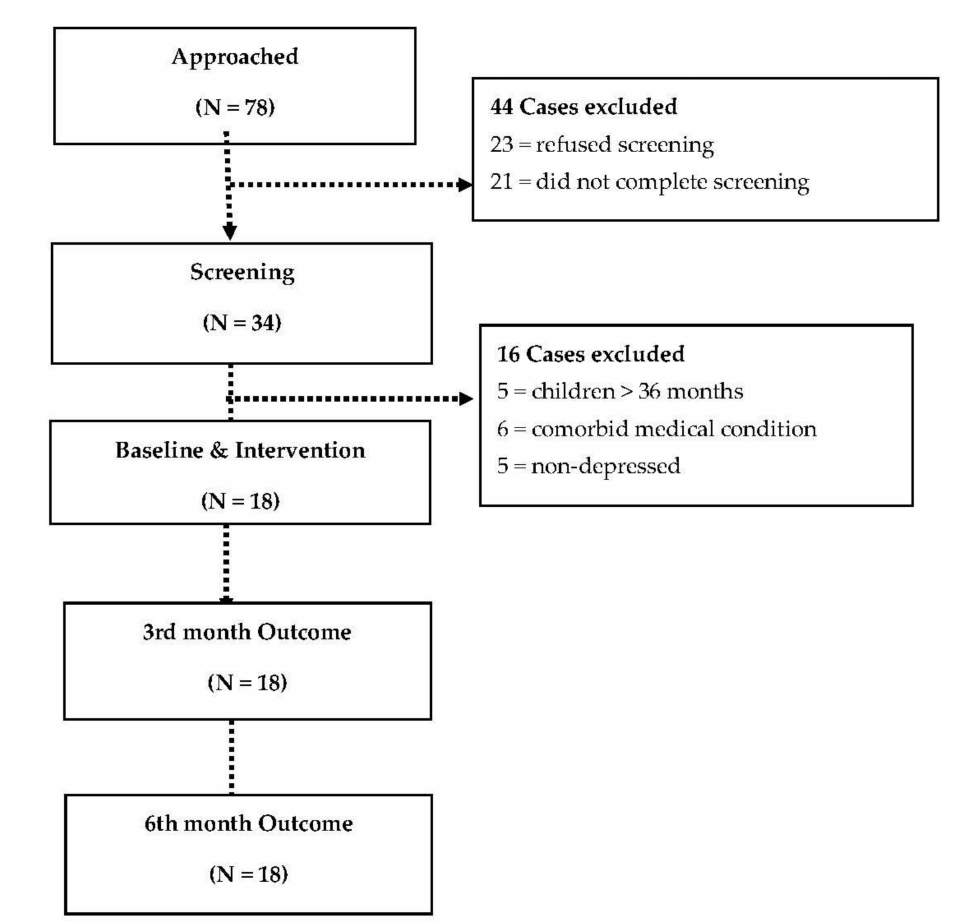
Figure 1. Consolidated Standards of Reporting Trials—CONSORT flow